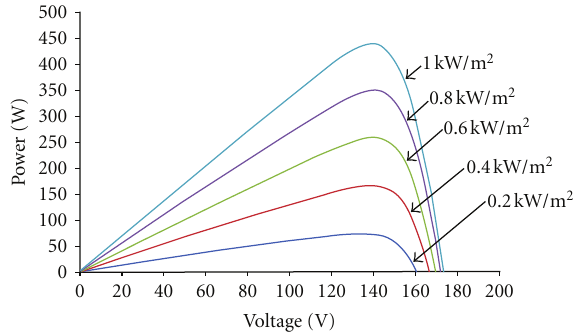
Figure 5: The P - V characteristic curve of solar cells under di ff erent sunlight